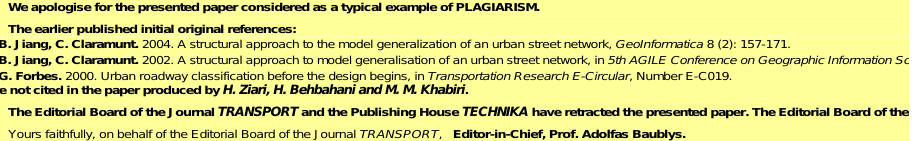
Fig 2. Respective integration/connection of nodes a and